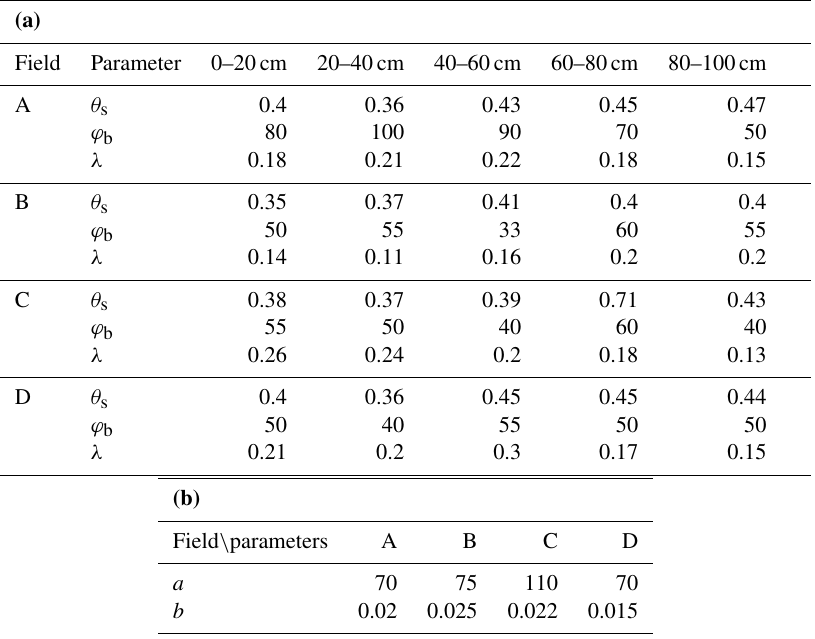
Table 3. (a) Calibrated soil hydraulic parameters in the Brooks and Corey soil moisture characteristic curve. (b) Calibrated groundwater